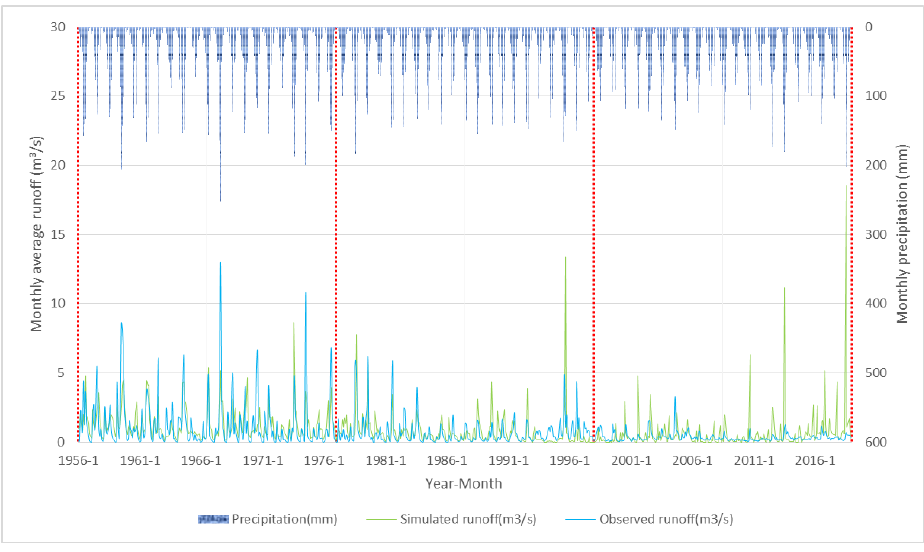
Figure 12. Simulated results of S2 (CCS).